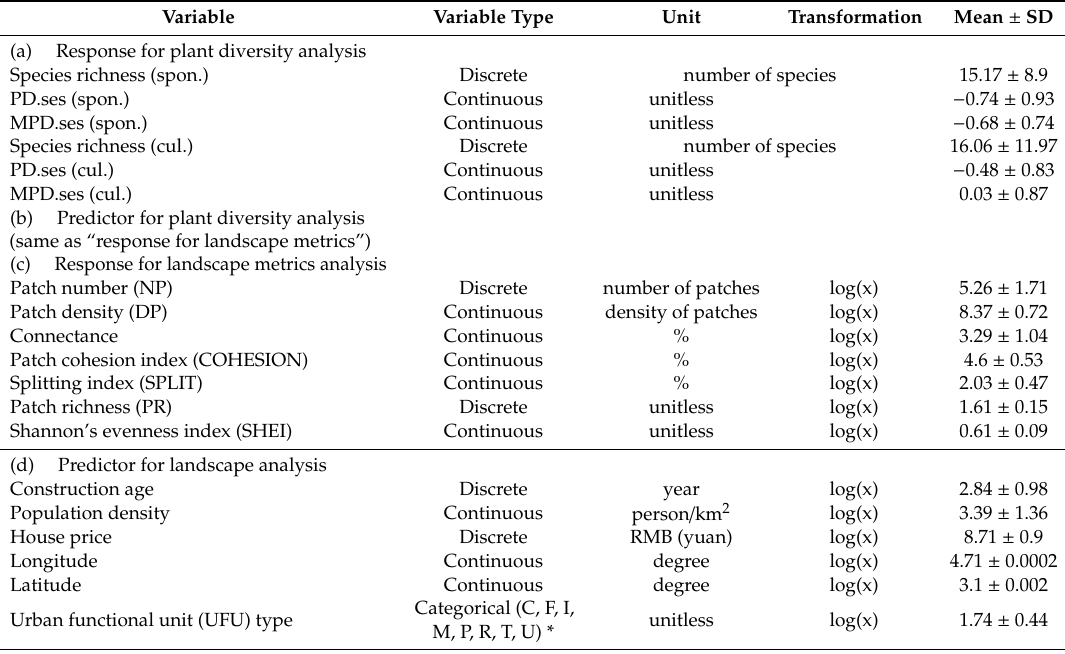
Table 5. Summary of response and predictor variables used in linear regression models (LM) to analyze plant diversity and landscape pattern; “spon.” and “cul.” refer to the spontaneous and cultivated species pools, respectively.